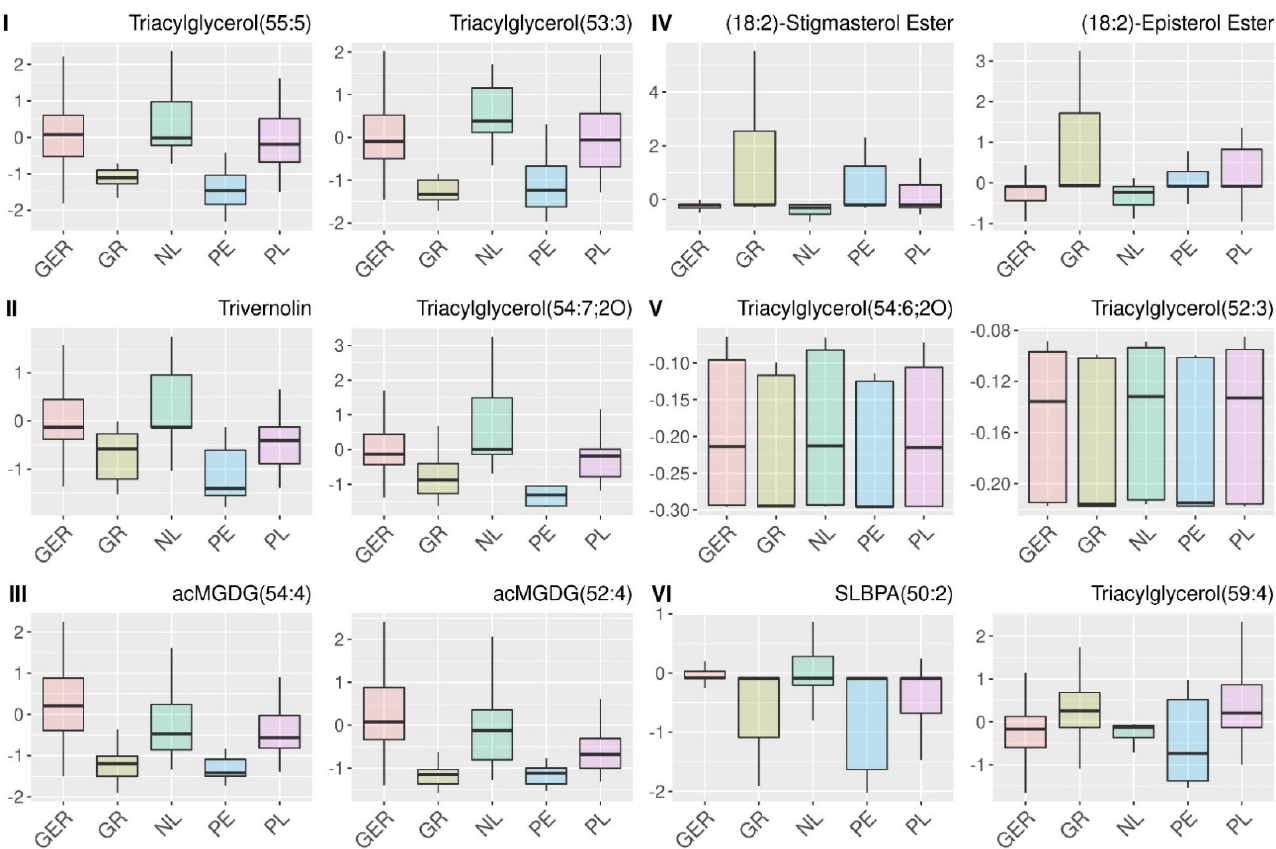
Figure 4. Boxplots of the autoscaled intensities for two exemplary metabolites of the clusters ( I – VI ) from the relation analysis Figure 3. A. Detailed information about the metabolites can be obtained from Table S7. Abbreviations: acMGDG: acylated monogalactosyldiacylglycerols; SLBPA: semi-lyso-bis-phosphatidic acid.